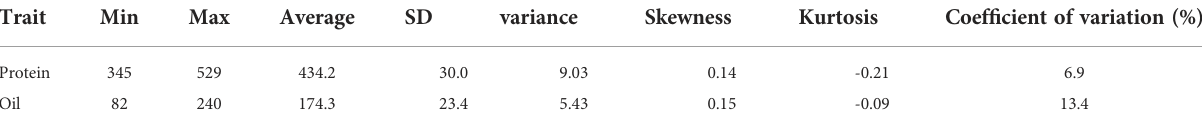
TABLE 1 Descriptive statistical analysis of the protein and oil content (mg/g) of 1,007 soybean germplasms grown at Urbana, IL, in 2001 and 2002.